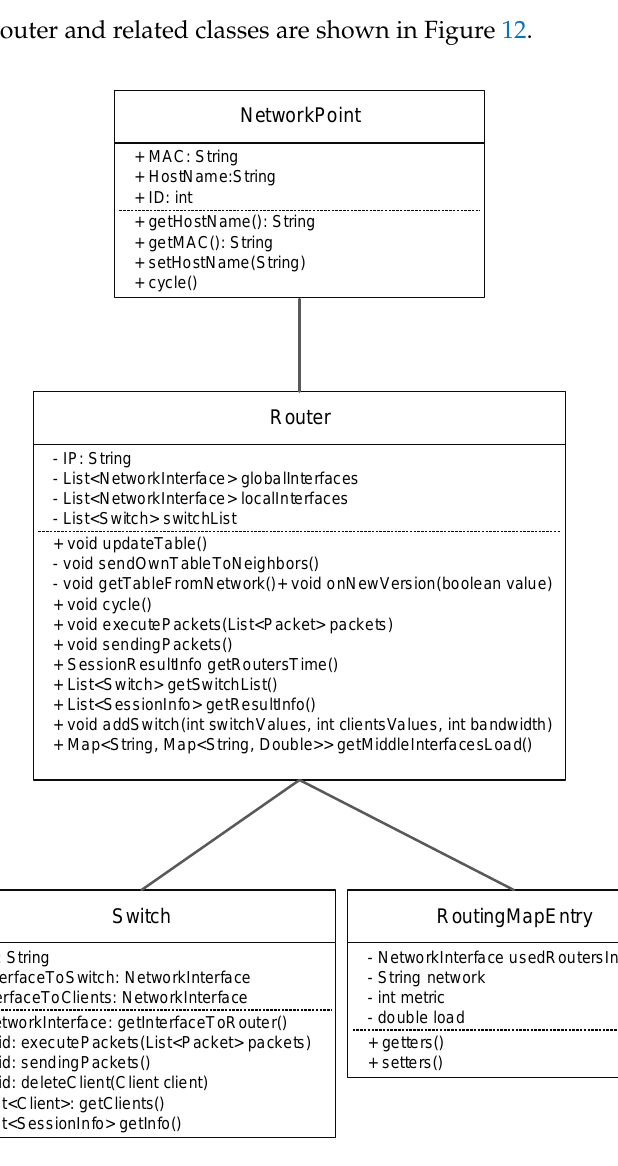
Figure 12. The UML diagram for router class.